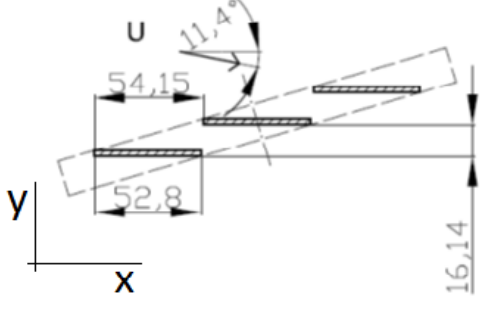
Fig. 1. Test geometric configuration of the simplified cascade which consists of three oscillating flat plates. The dimensions are in millimetres. The width of the plates is 0.08m.